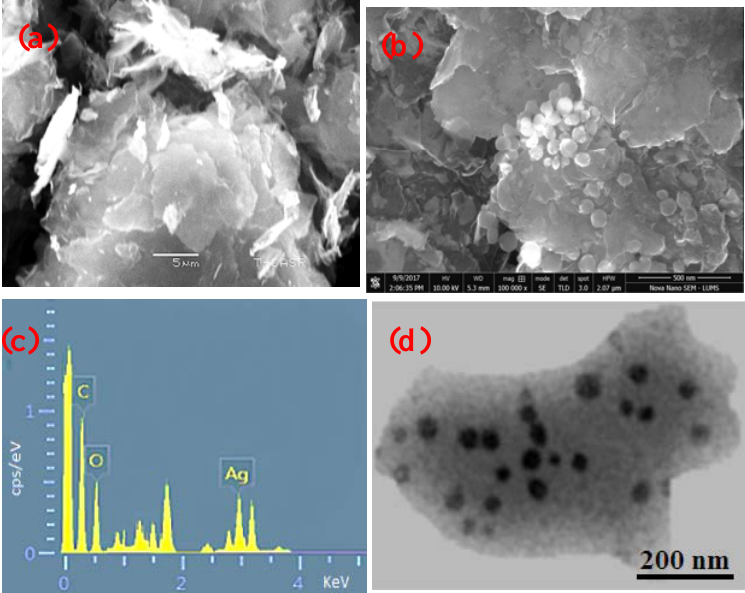
Figure 2. Scanning Electron Microscopy (SEM) analysis of ( a ) GO ( b ) GO ‐ Ag nanocomposites ( c ) Energy Dispersive X ‐ rays (EDAX) analysis of GO ‐ Ag nanocomposites ( d ) Transmission electron microscopy (TEM) of GO ‐ Ag.